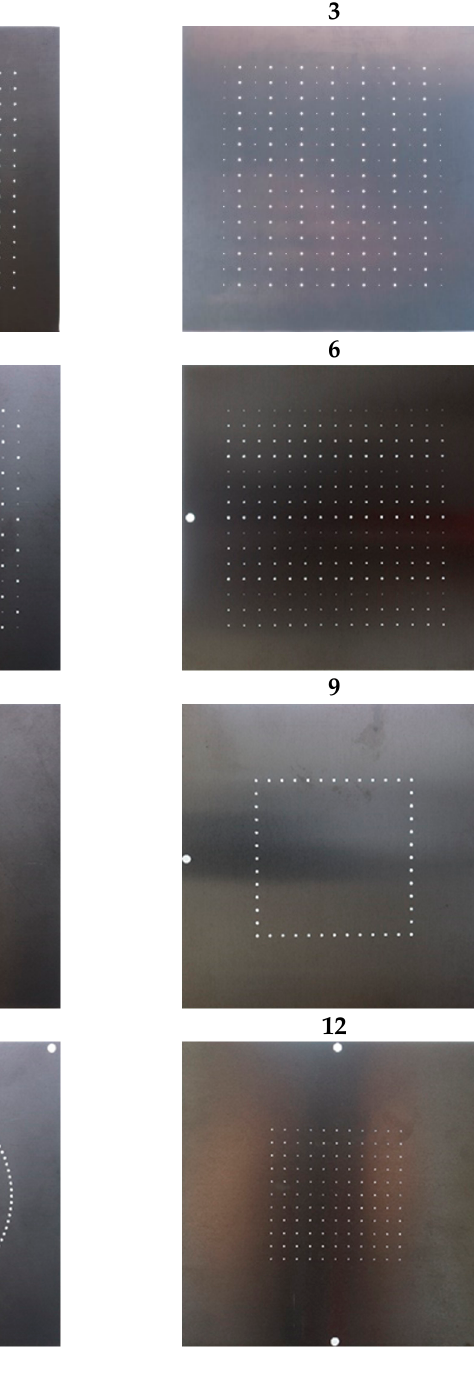
Figure 3. Photographs of specimens 1–12. Table 1. The parameters of specimens 1–12.